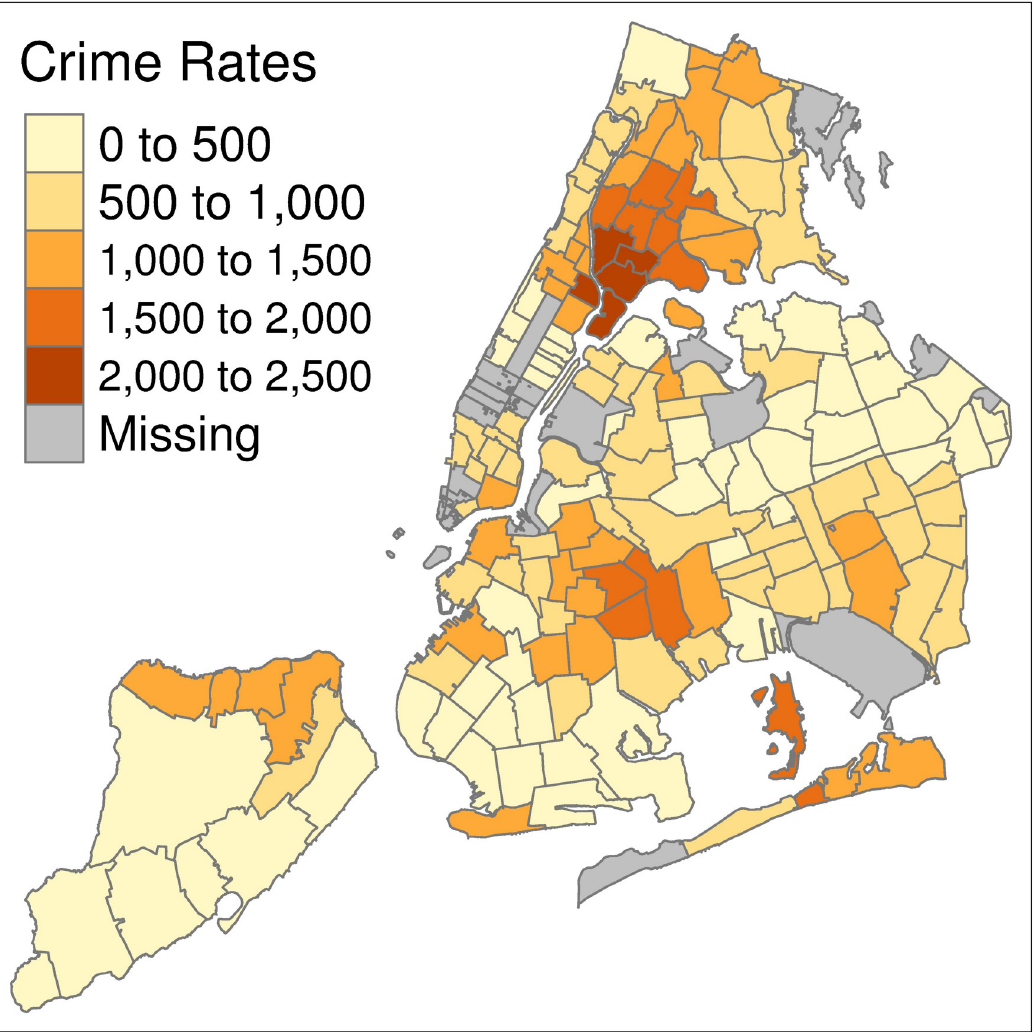
Fig 3. Assault crime rates 2017. 2017 Assault crime rates for ZIP codes in New York